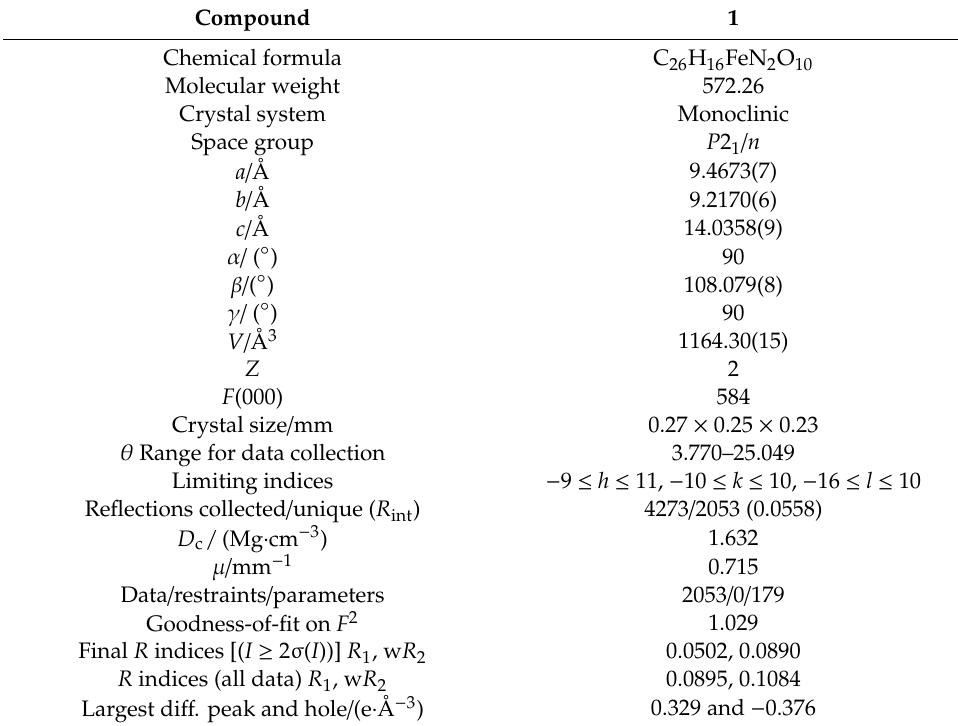
Table 1. Crystal structure parameters for coordination polymer 1